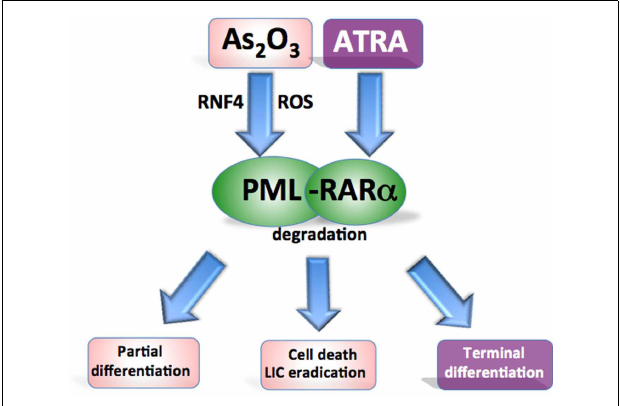
FIGURE 3 |Targeting oncogenic PML in acute promyelocytic leukemia . Both agents target the PML-RAR α fusion protein for degradation. ATRA promotes RAR α -target gene transcription to overcome the differentiation block while As 2 O 3 induces oxidant stress and directly binds PML to cause partial differentiation and apoptosis of APL cells and more effectively eradicate leukemia-initiating